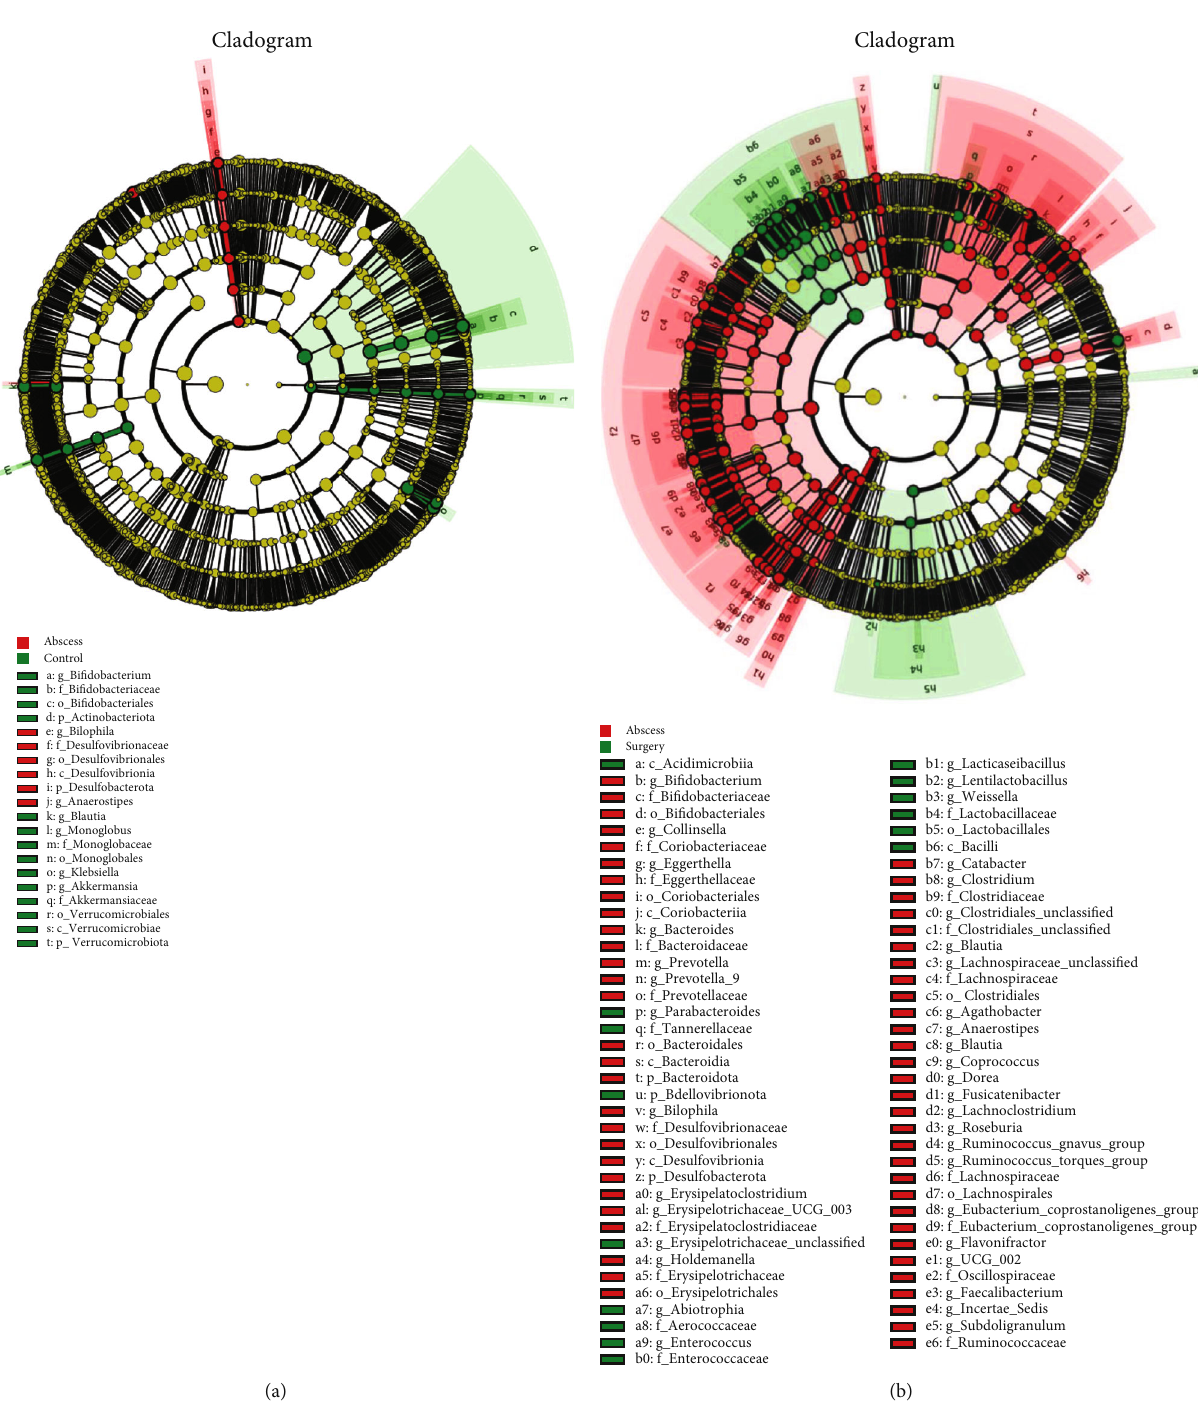
Figure 7: Linear discriminant analysis e ff ect size (LEfSe) analysis of the di ff erences in the composition of gut microbiota composition between (a) control and abscess groups and (b) abscess and surgery groups. The di ff erent circle layers show evolutionary relationships among the six taxonomic levels of phylum, class, order, family, genus, and species from the inside to the outside. The larger nodes of each level represent higher abundance of the species. The yellow and red nodes indicate the insigni fi cant and signi fi cant di ff erences of the species from the control group. The gates with signi fi cant di ff erences are directly marked in the fi gure, and the species nodes with other di ff erent levels are marked with letters, which speci fi cally represent